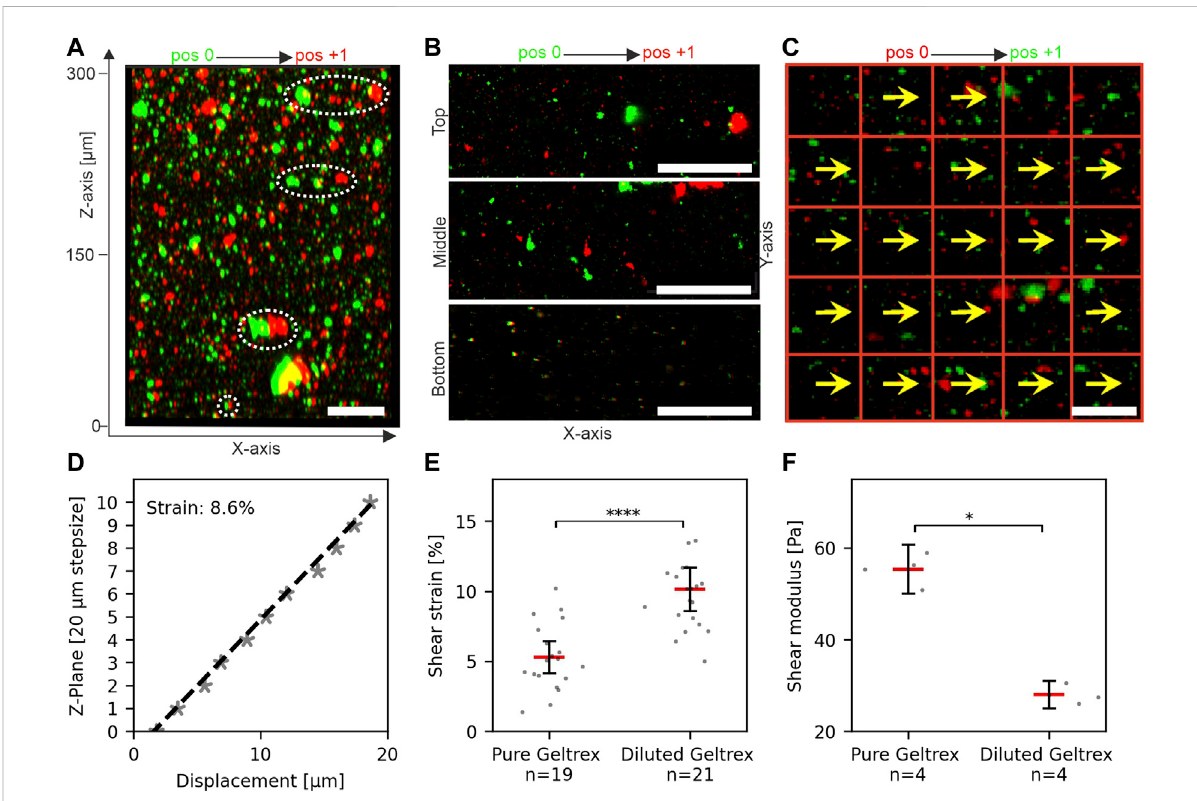
FIGURE 3 Measurement and quanti fi cation of shear strain in hydrogels. (A) Reconstructed image stack of fl uorescent microspheres in an unstrained (pos 0, green) and strained (pos +1, red) hydrogel. White ellipses highlight the height-dependent increase of bead displacements. (B) Representative micrographs show bead displacements parallel to sled movement and applied force ( x -axis). (C) Template displacements for an individual focus plane. Displacement vectors (DVs) (yellows arrows) are given for templates (red squares). (D) Linear regression (dashed line) was used to determine the applied shear strain within the gel. Each data point represents the median displacement of all detected DVs in the respective plane. Value0 µm:indicatesthe fi rstplaneoftherecordedimagestack (absolutegelheight > 300 µm).Thelocalstrainwascalculatedfromtheslopeofthe regression line. (E) Scatter plots of shear strain in pure and diluted hydrogels at 5 mm sled movement, i.e ., identical shear force. N = total number of measurements from three individual gels. The threshold for linear regression was r 2 > 0.7. (F) Shear moduli of pure and diluted hydrogels as determined by rheology. N = total number of measured gels. Red bars in scatter plots: mean, bars 95% con fi dence interval. For statistical tests, the Mann – Whitney U -test was used with: **** = p < 0.0001, * = p < 0.05. Scale bars: 50